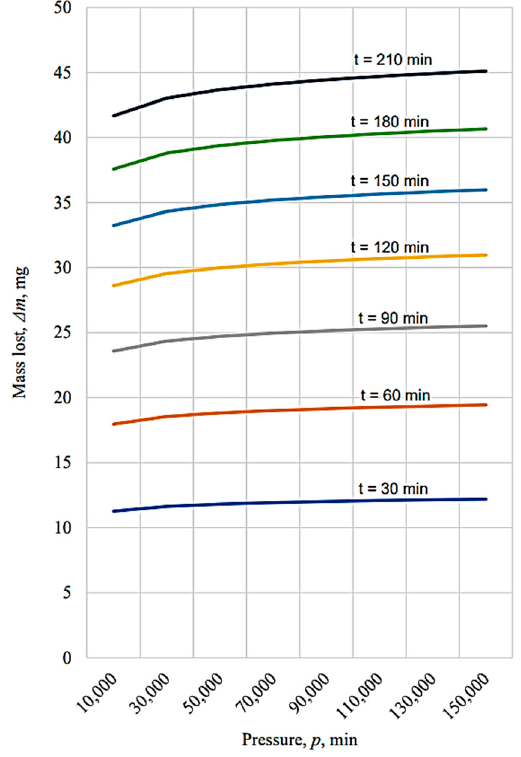
Figure 13. The influence exerted by the pressure on the mass lost ∆ m for different durations of the process applied to the tested surface in the case of the vibroburnishing